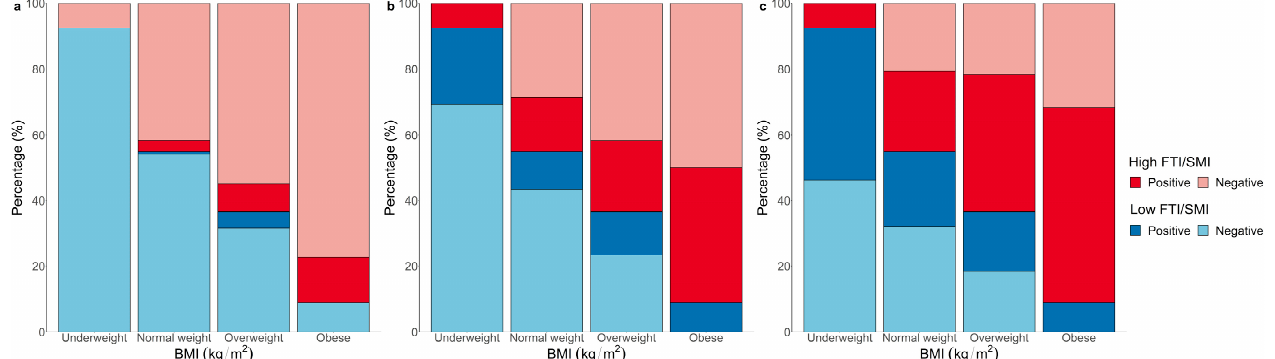
Figure 5. Bar plots showing the percentage of patients with combinations of low or high FTI/SMI ratios and corresponding positive or negative clinical outcomes in each BMI group. ( a ): Mortality within 28 days; ( b ): Mechanical ventilation; ( c ): ICU length of stay ≥ 5 d. BMI, body mass index; FTI, fat tissue index; SMI, skeletal muscle